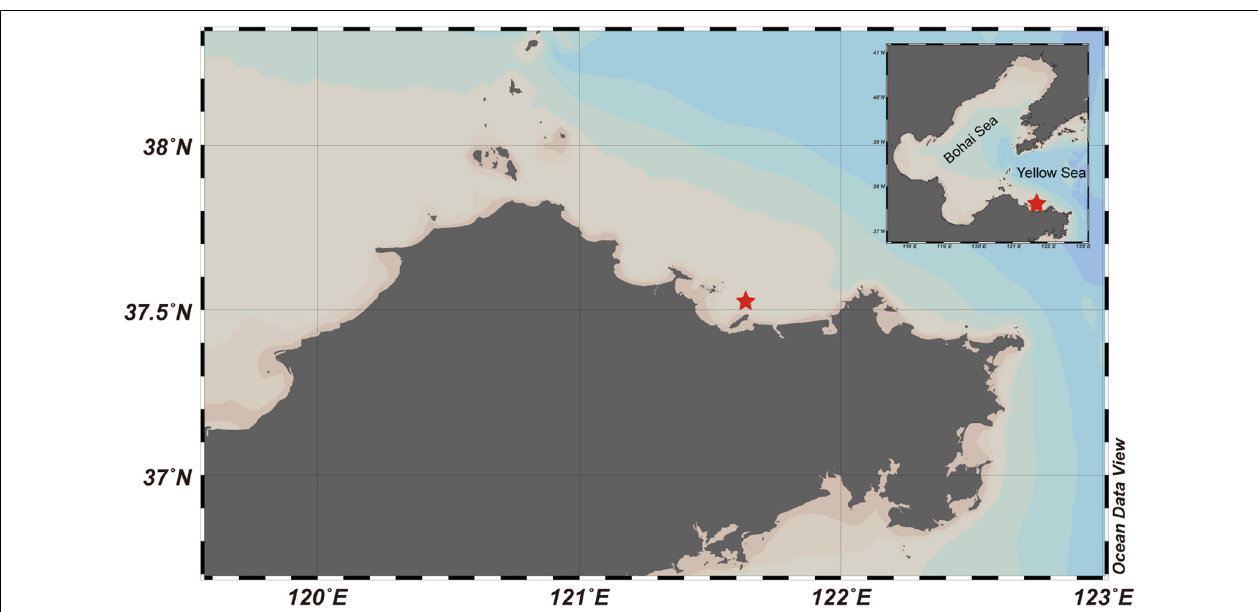
FIGURE 1 | Map of Muping Marine Ranch (Yantai) with a star ( (cid:70) ) showing the sampling area. Samples were collected from the surface and bottom of the sea on August 10,